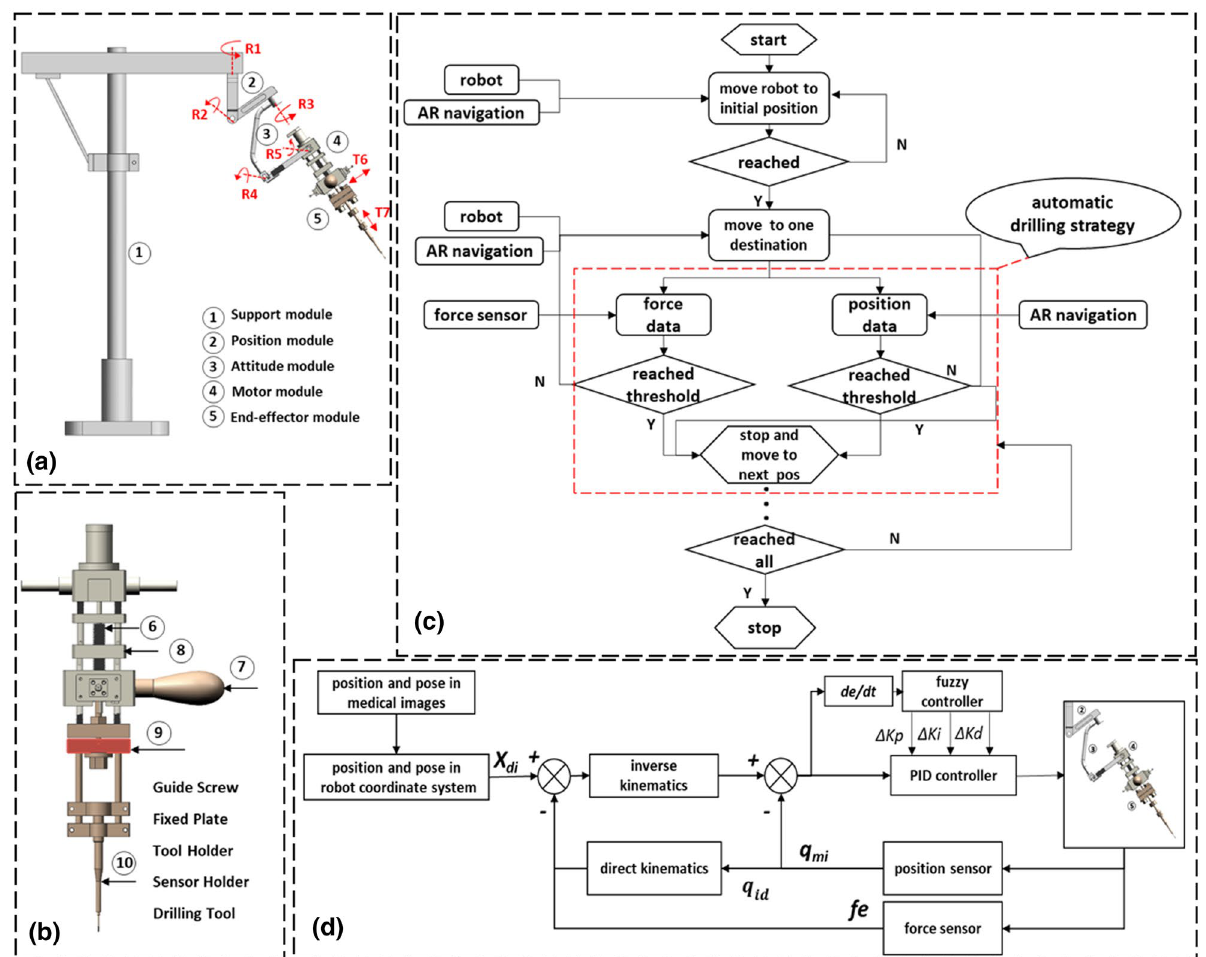
Figure 5. The robot system: ( a ) the structure frame diagram; ( b ) the structure of the force feedback system; ( c ) the automatic drilling strategy diagram; ( d ) the structure of the control